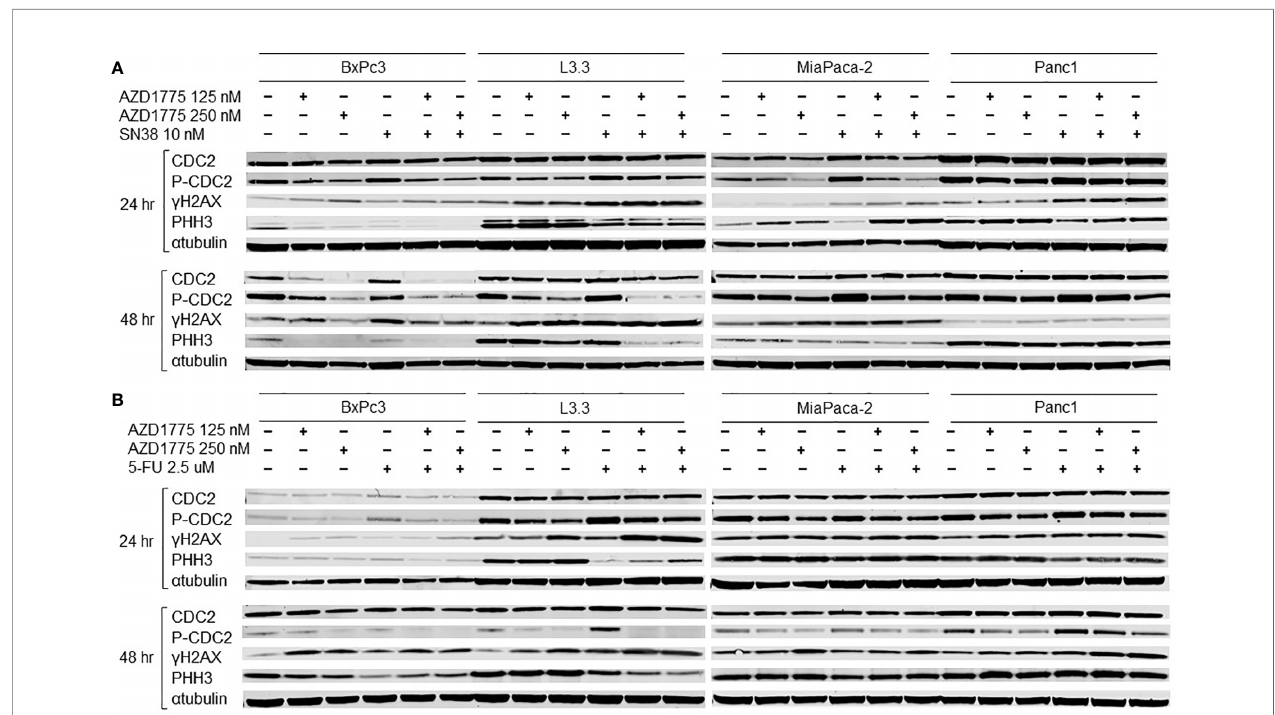
FIGURE 6 | Effects of AZD1775 and (A) SN38 or (B) 5-FU on downstream effectors of DNA damage and cell cycle in PDAC cell lines. Cells were treated AZD1775 and SN38 or 5-FU for 24 and 48 hours then total protein was extracted. Expression of CDC2, p-CDC2, g H2AX, and PHH3 was measured with